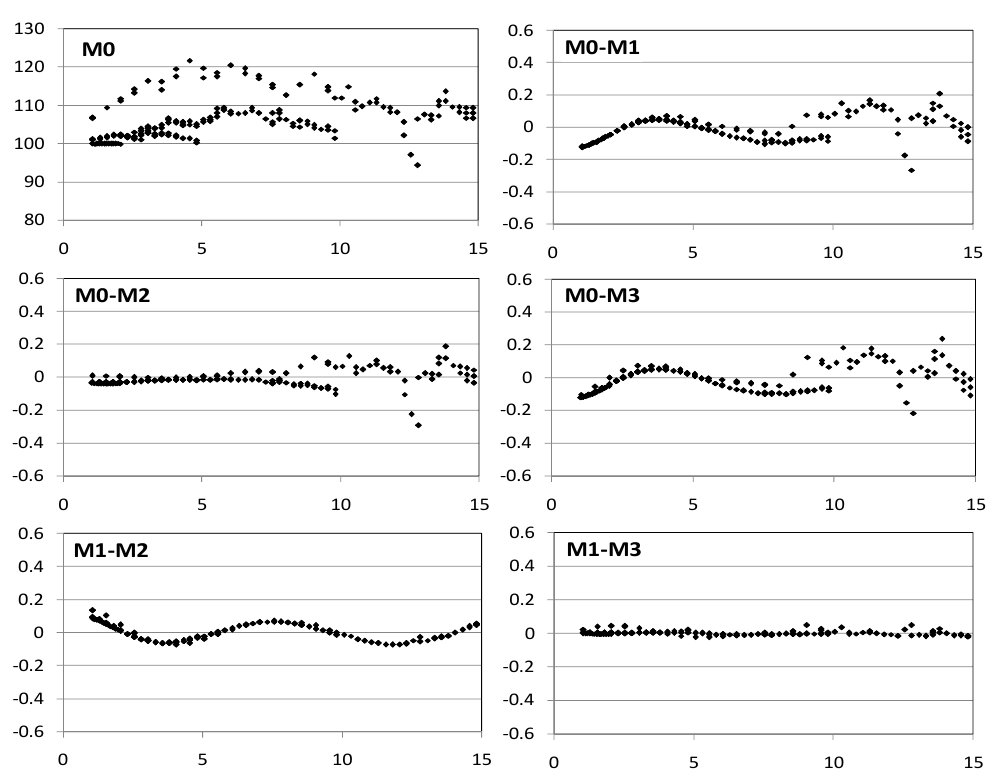
Figure 3. M0 model prices and differences of model prices on 31 October 2008.